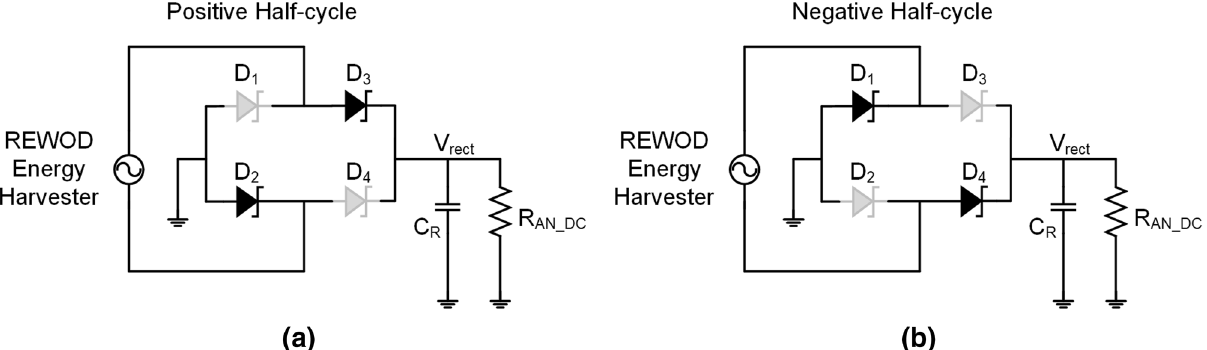
Figure 4. Schematic of the Schottky diode-based bridge rectifier, ( a ) working principle of the proposed rectifier during positive half-cycle, and ( b ) working principle of the proposed rectifier during negative